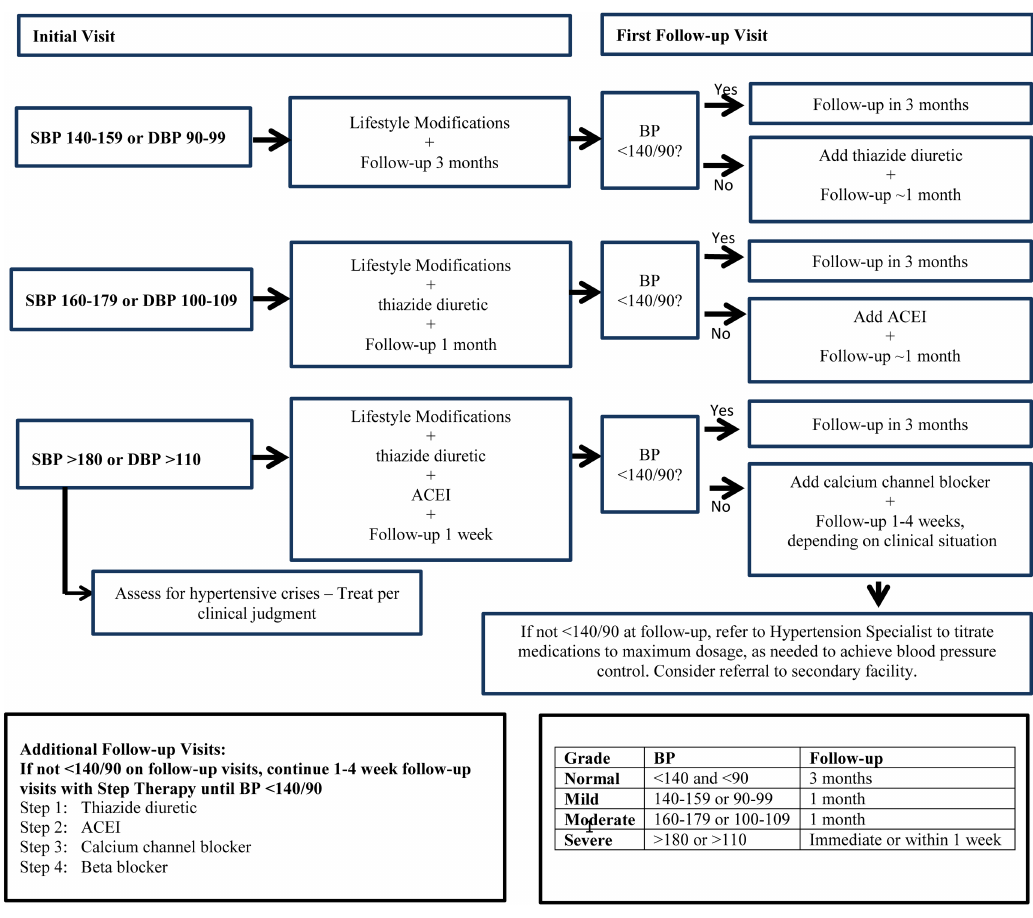
Fig 1. Suggested algorithm for treatment of hypertension among human immunodeficiency virus (HIV)-infected persons. ACEI, angiotensin-converting enzyme inhibitor; BP, blood pressure; DBP, diastolic blood pressure; SBP, systolic blood pressure.